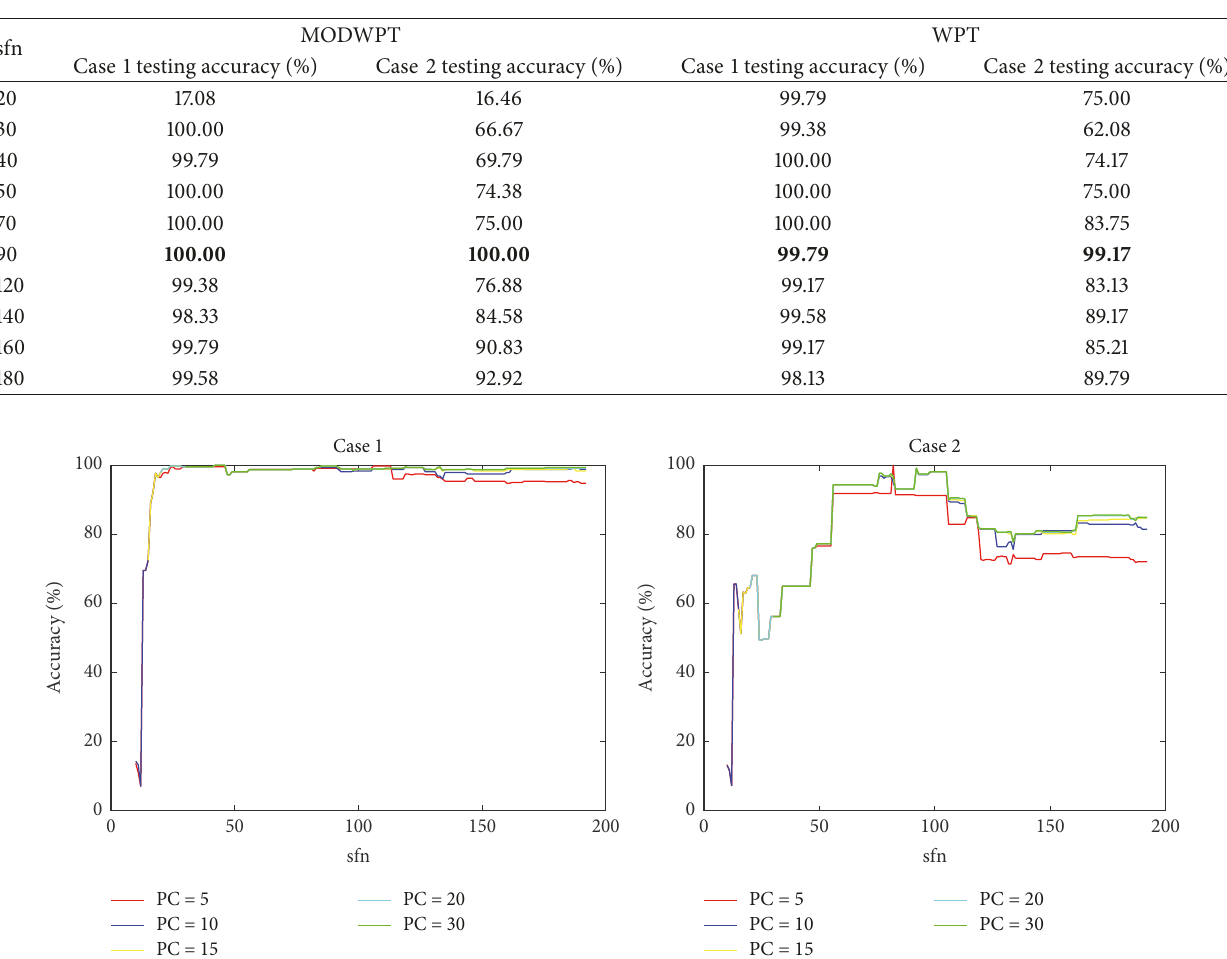
Table 12: Bearing fault diagnosis results obtained by OFS-FSASD-SNPEL-SVM (dimension size is 20).